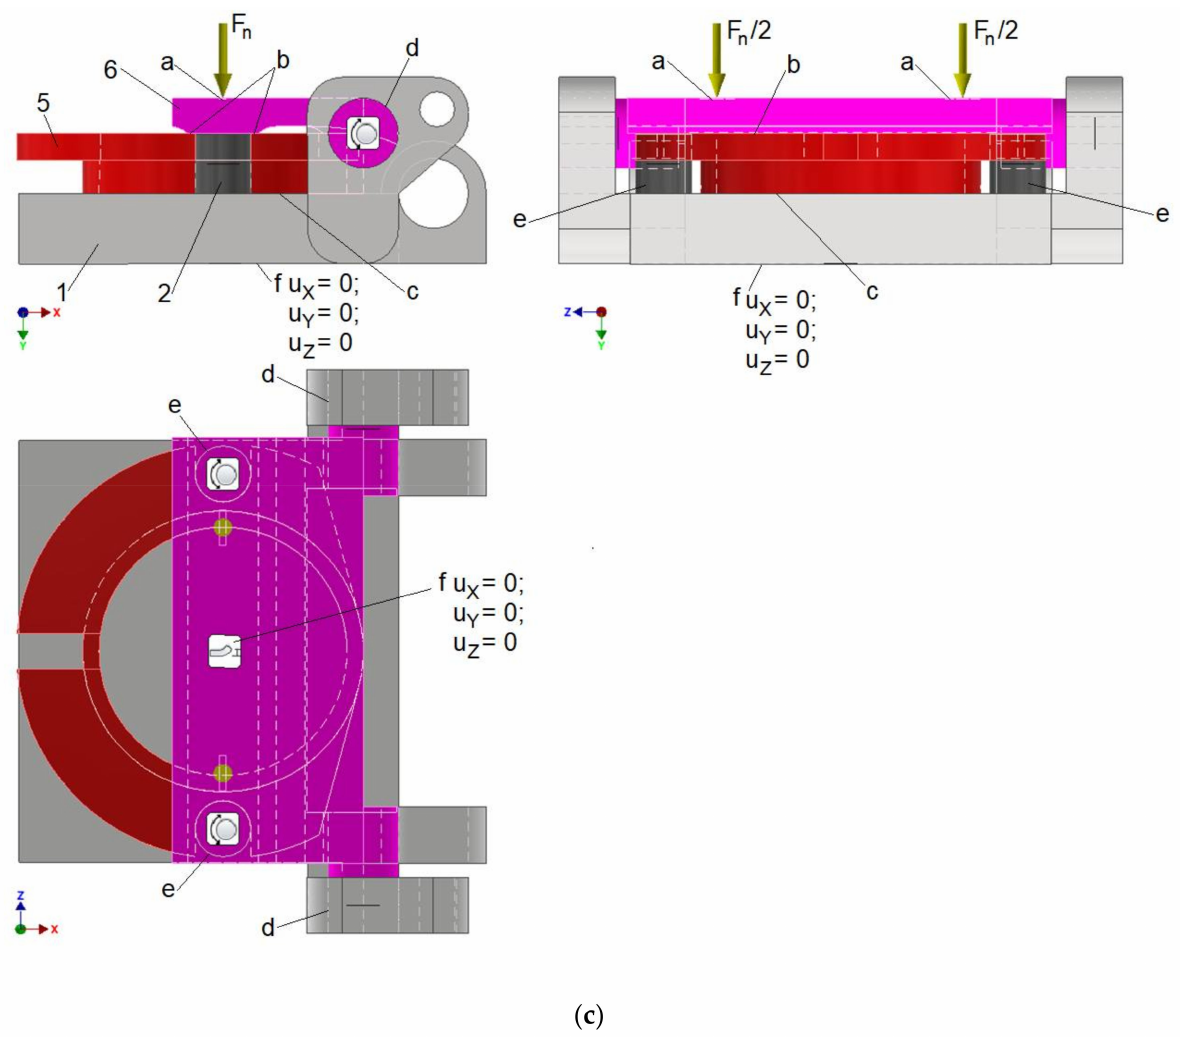
Figure 5. The model for determining contact pressure between eccentric and swivel arm. ( a ) Geometry of components; ( b ) Finite element grid; and ( c ) Boundary conditions.